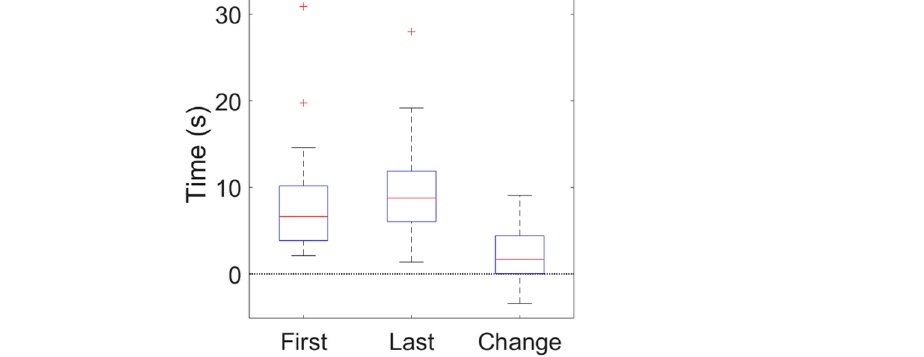
Figure 4. Distributions of microphone-based maximum phonation time for speakers’ first day before treatment (First), last day after treatment at discharge (Last), and first-to-last day changes (Change). Each box–whisker plot indicates median (horizontal line within box), interquartile range between 25th and 75th percentiles (box bounds), minimum value within 1.5 times the interquartile range away from the bottom of the box (lower whisker bound), maximum value within 1.5 times the interquartile range away from the top of the box (upper whisker bound), and outliers that exist outside these minimum and maximum values (+ symbols).